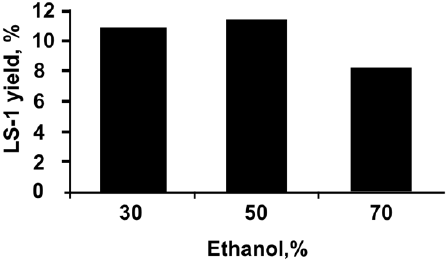
Figure 2. Elaborating optimal technology for LS-1: choosing correct concentration of extragent.